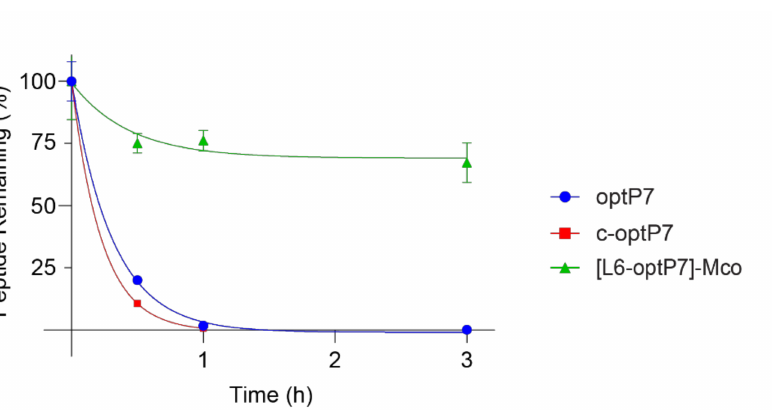
Figure 4. Stability of peptides in human serum. Percentage of peptide remaining over three hours, data shown as mean ± SD from experiments performed in triplicates.